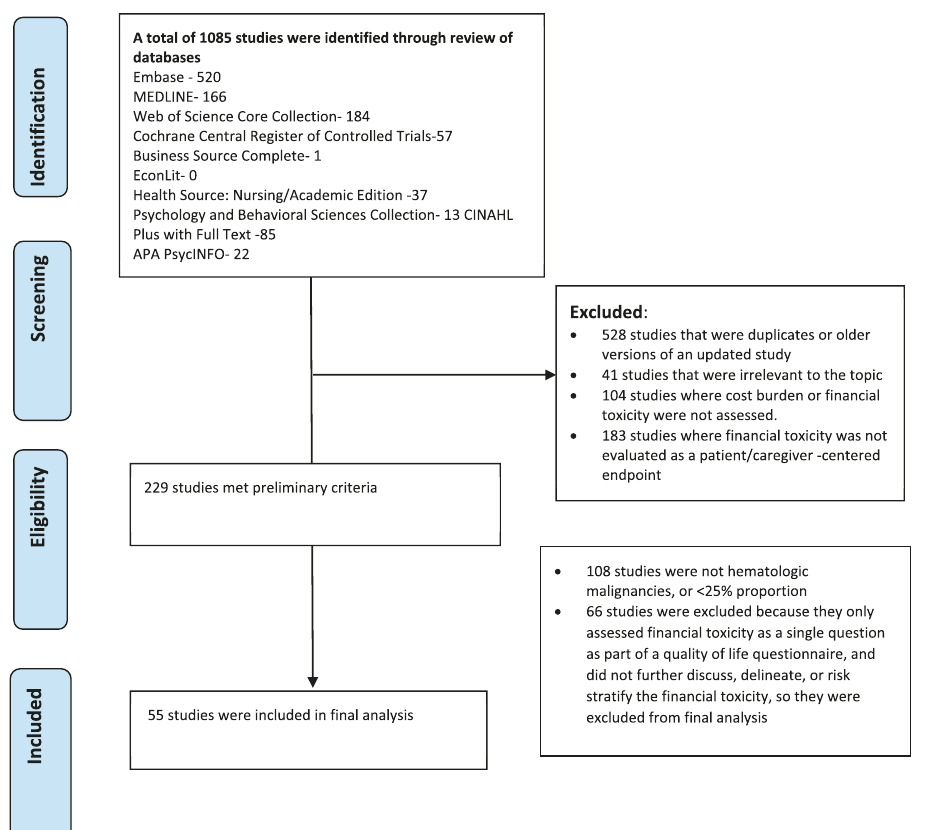
Fig. 1 Flow diagram of study selection. The process of short-listing fi nal list of included studies is